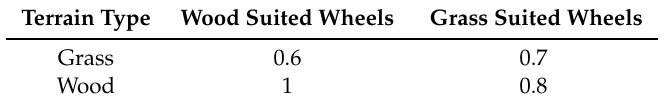
Table 6. Speed Coefficients for Heterogeneous Robot Wheels on Different